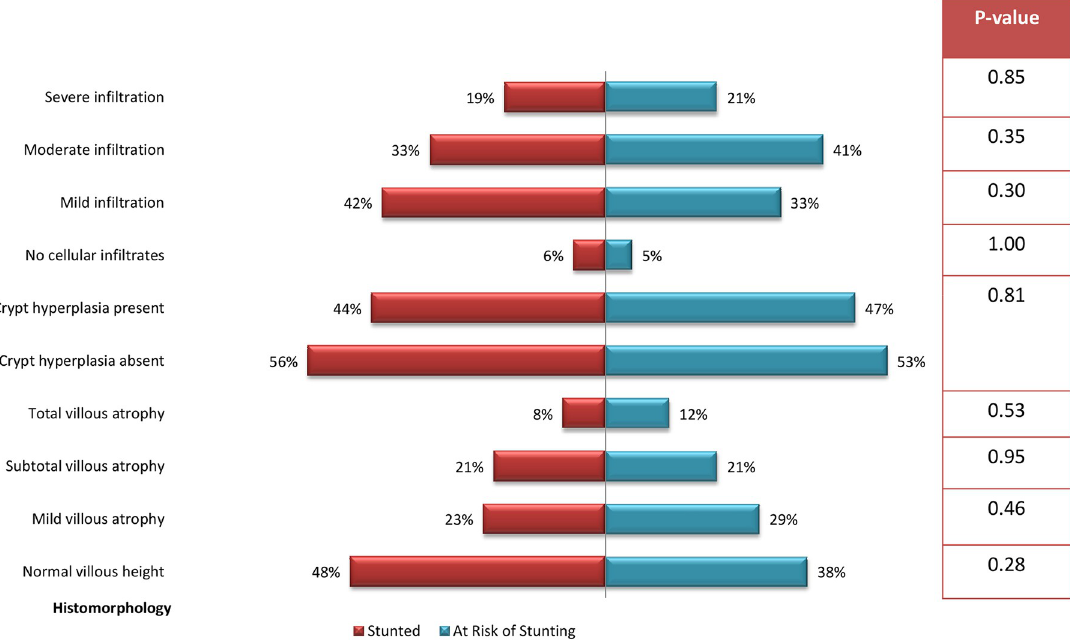
Fig 2. Histomorphological features of upper GI mucosa in children with